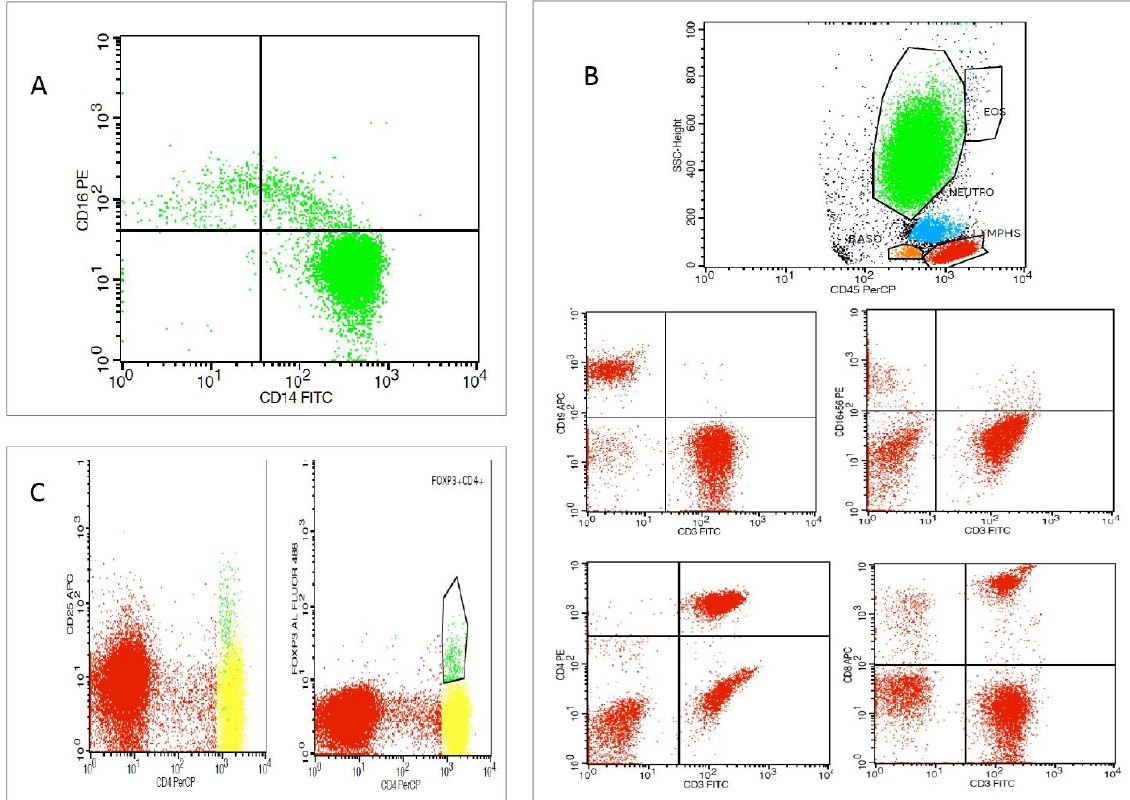
Figure 2. Flow cytometric analysis of a type 2 CRS patient. ( A ) Representative dot plots depicting monocyte subsets (green clolour) with regard to surface expression of CD14 and CD16 in CD14++CD16 − , CD14++C16+, and CD14+CD16+ subpopulations. ( B ) Representative dot plots depicting lymphocyte gating (red colour) with B-lymphocytes, T-lymphocytes, and natural killer (NK) cells defined as CD16+CD56+ cells, CD4+ T cells, and CD8+ T cells. ( C ). Representative dot plots depicting T regulatory cells (Tregs) defined as CD4+ FoxP3+ CD25 high positive cells (green colour).